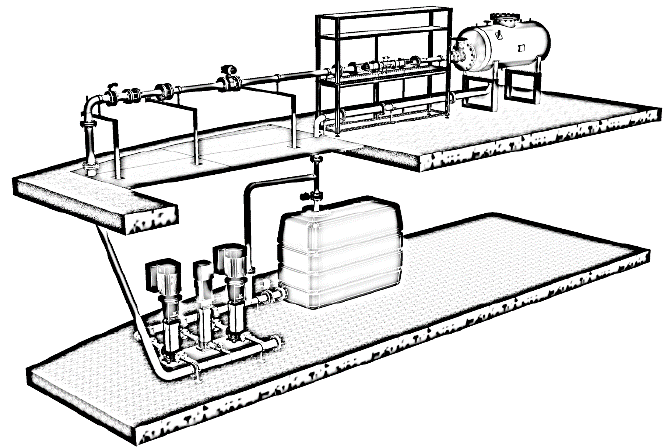
Figure 3. Hydraulic test rig (2016 version) of the HES-SO Valais//Wallis—Switzerland [12]. (Main characteristics: (1) Maximum head: 160 mWC; (2) Maximum discharge: ±100 m 3 /h; (3) Generating power: 20 kW; (4) Pumping power: 2 × 18.5 kW and 1 × 5.5 kW; (5) Maximum pumps’ speed: 3500/3000 min −1 ; (6) Total circuit volume: 4.5 m 3 ).